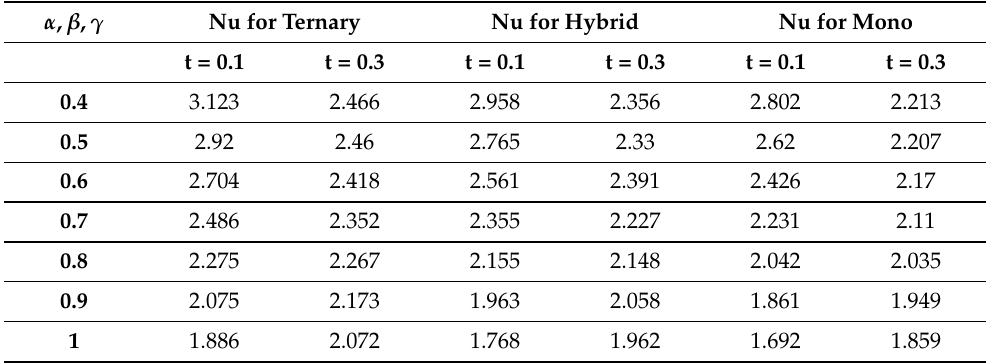
Table 3. Effect of time and fractional parameter on Nusselt number (ternary, hybrid and mono